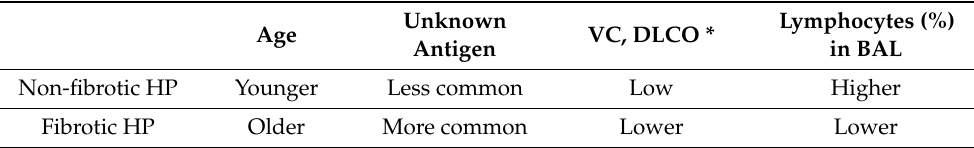
Unknown Age VC, DLCO * Antigen